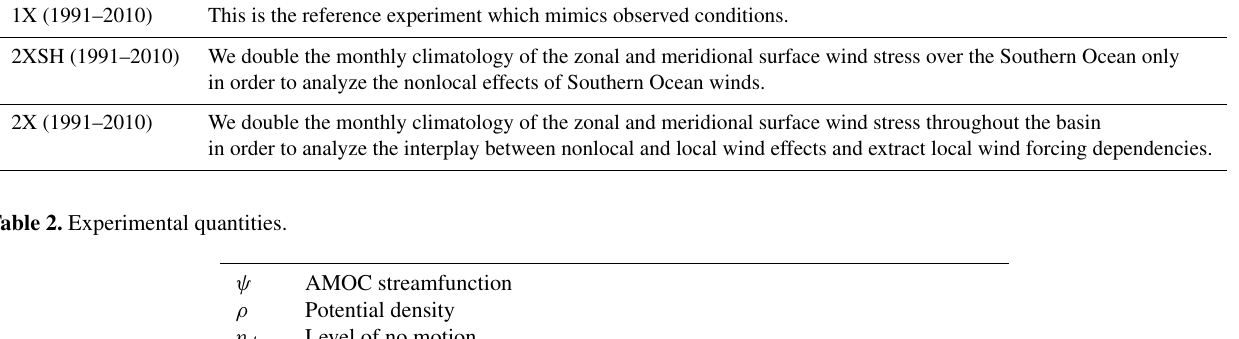
Table 1. Overview of the experimental strategy.